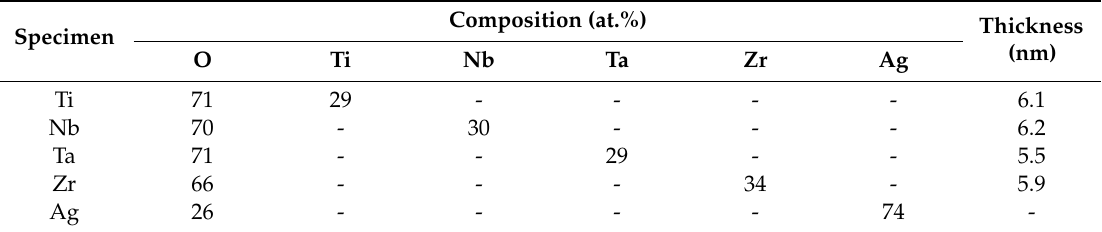
Table 1. The composition and thickness of the passive layer on each metal specimen calculated from the XPS measurement with a detection angle of 90 ◦ .